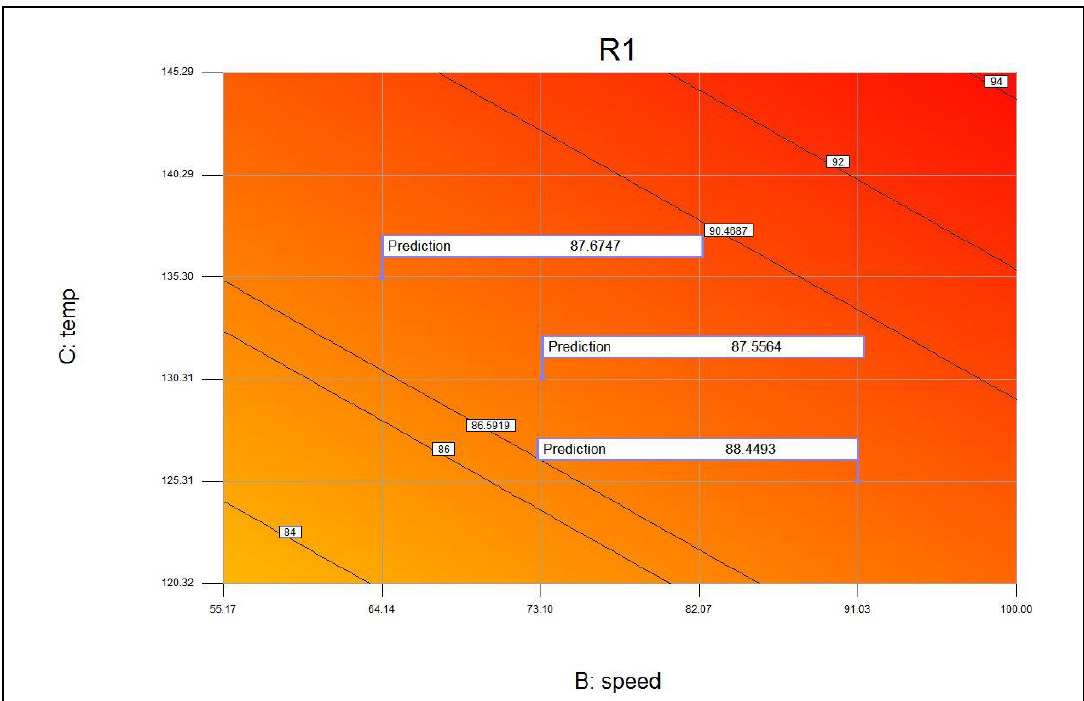
Figure8. Designofspaceofa2-levelfactorialdesignwithoutacenterpoint, foranoptimumformulation. Figure 8. Design of space of a 2-level factorial design without a center point, for an optimum formulation.